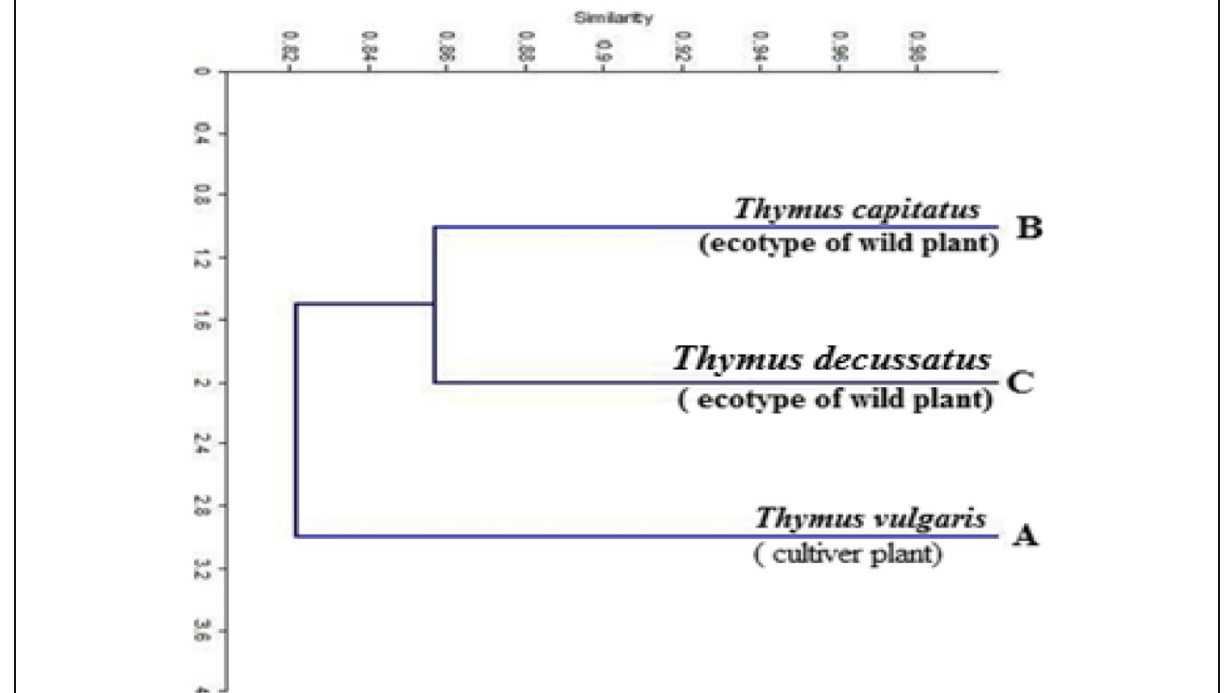
Fig. 4 The genetic relatedness within (A) Thymus vulgaris (cultivated type collected from Kirdasa region), (B) Thymus capitatus (wild type collected from North Coast), and (C) Thymus decassatus (wild type collected from Saint Catherine) based on AFLP